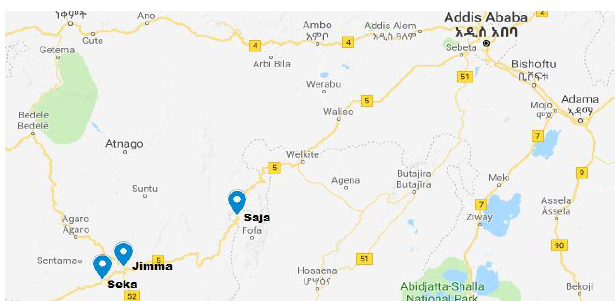
Figure 2. Locations of hospitals included in the study. Saja is 240 km Southwest of Addis Ababa, Jimma is 350 km Southwest of Addis Ababa and Seka is 373 km Southwest of Addis Ababa.